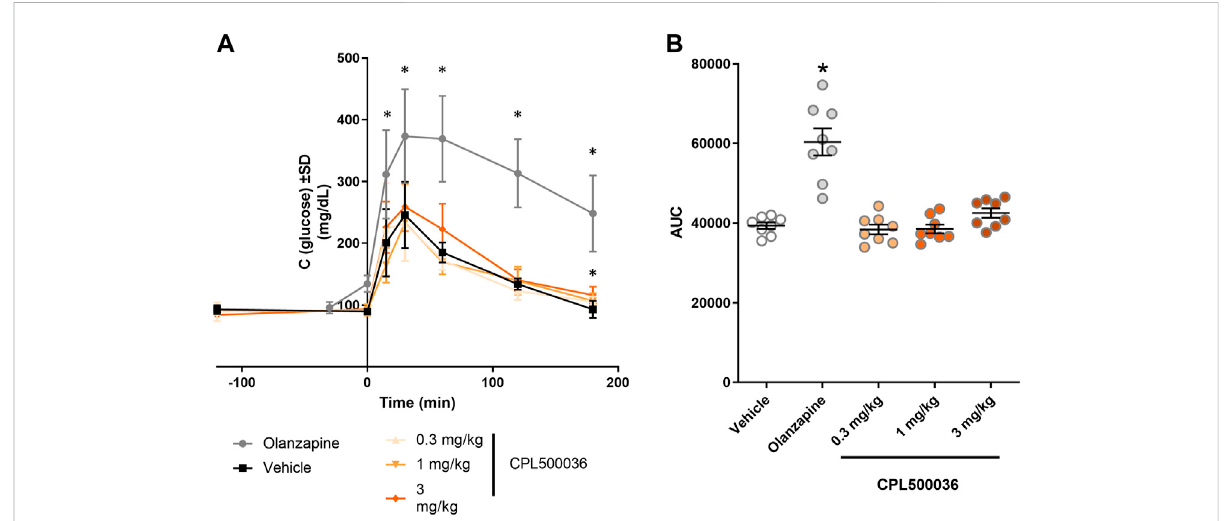
FIGURE 6 CPL500036 has no effect on the glucose level. The glucose-tolerance test was carried out 2 h after administration of CPL500036 (0.3 mg/kg, 1 mg/kg, and 3 mg/kg, p.o.) or olanzapine (10 mg/kg, s.c.). The glucose concentration in blood in the course of time (A) and as the area under the curve (B) is presented. Data are the mean ± SD. * p < 0.05 vs. vehicle group by Dunn ’ s post hoc test; n =